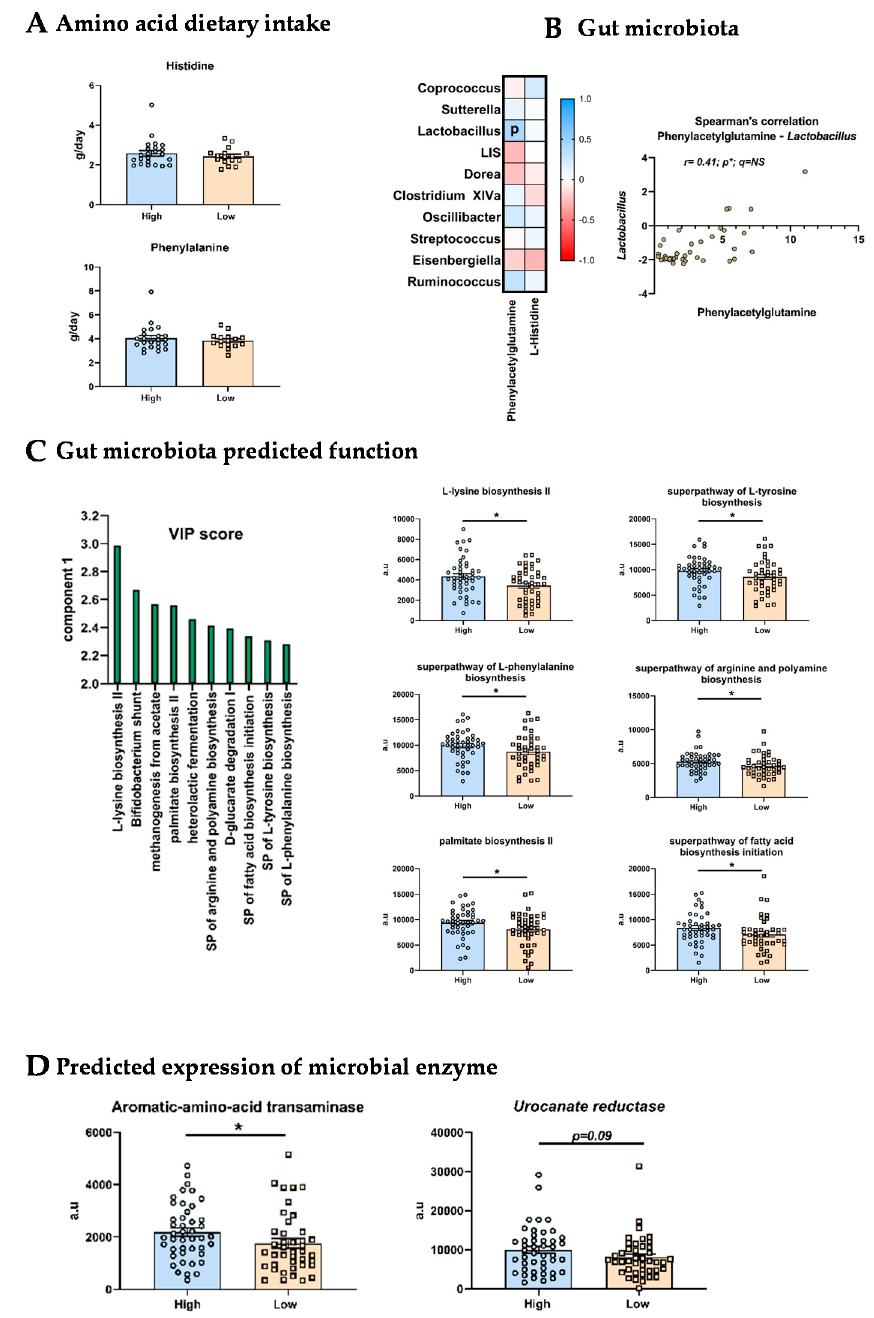
Figure 2. Origins of the altered serum metabolite profile. ( A ) Dietary intake of amino acids in High and Low mood score groups. ( B ) Spearman’s correlation matrix between metabolites and genera of interest. Significant ( p < 0.05) correlation were highlighted with “p”. ( C ) PICRUSt2 analysis. Left part: graphical representation of the TOP10 MetaCyc pathways which segregate High and Low mood score groups (based on PLS-DA VIP scores). Right part: graphical representation of the six significantly different MetaCyc pathways between High and Low mood score groups. a.u: arbitrary unit ( D ) PICRUSt2 analysis. Graphical representation of the predicted expression of the aromatic amino-acid transaminase and the urocanate reductase. * p < 0.05.